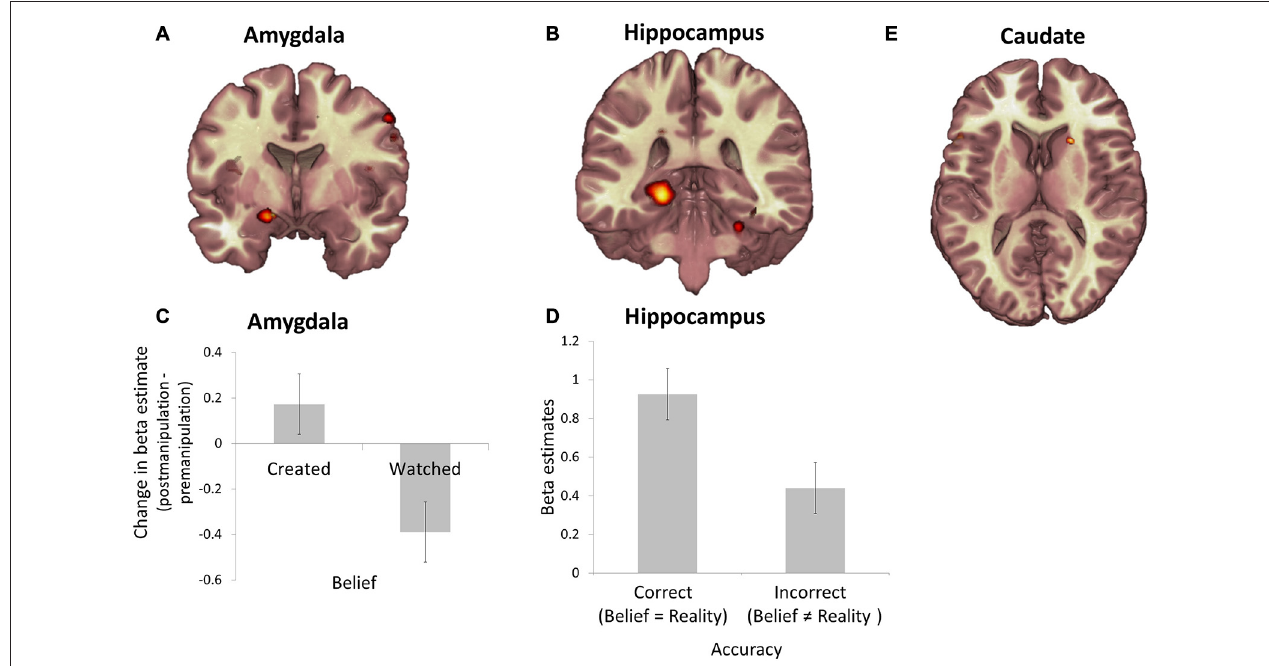
FIGURE 4 | Representation of subjective belief, veridical belief and value in the amygdala, hippocampus and caudate. Regions in which the BOLD response was significantly enhanced during belief expression relative to fixation included the (A) left amygdala and (B) left hippocampus (all p < 0.05, cluster level corrected). (C) During item presentation change in BOLD response during session 3 (post-manipulation) relative to session 1 (pre-manipulation) averaged across the voxels in the left amygdala was greater during presentations of shoes participants believed they created relative to shoes they believed they watched. (D) In contrast, BOLD response during belief expression across the voxels in the left hippocampus was greater during trials in which participants gave an accurate response (veridical belief of whether they created the shoe) relative to trials in which they gave an incorrect belief judgment. (E) BOLD response in the right caudate nucleus during shoe presentation over both sessions correlates with the value participants assigned to the shoes ( p < 0.05 FWE, small volume corrected). Error bars show within subject standard error of the mean (Cousineau, 2005).